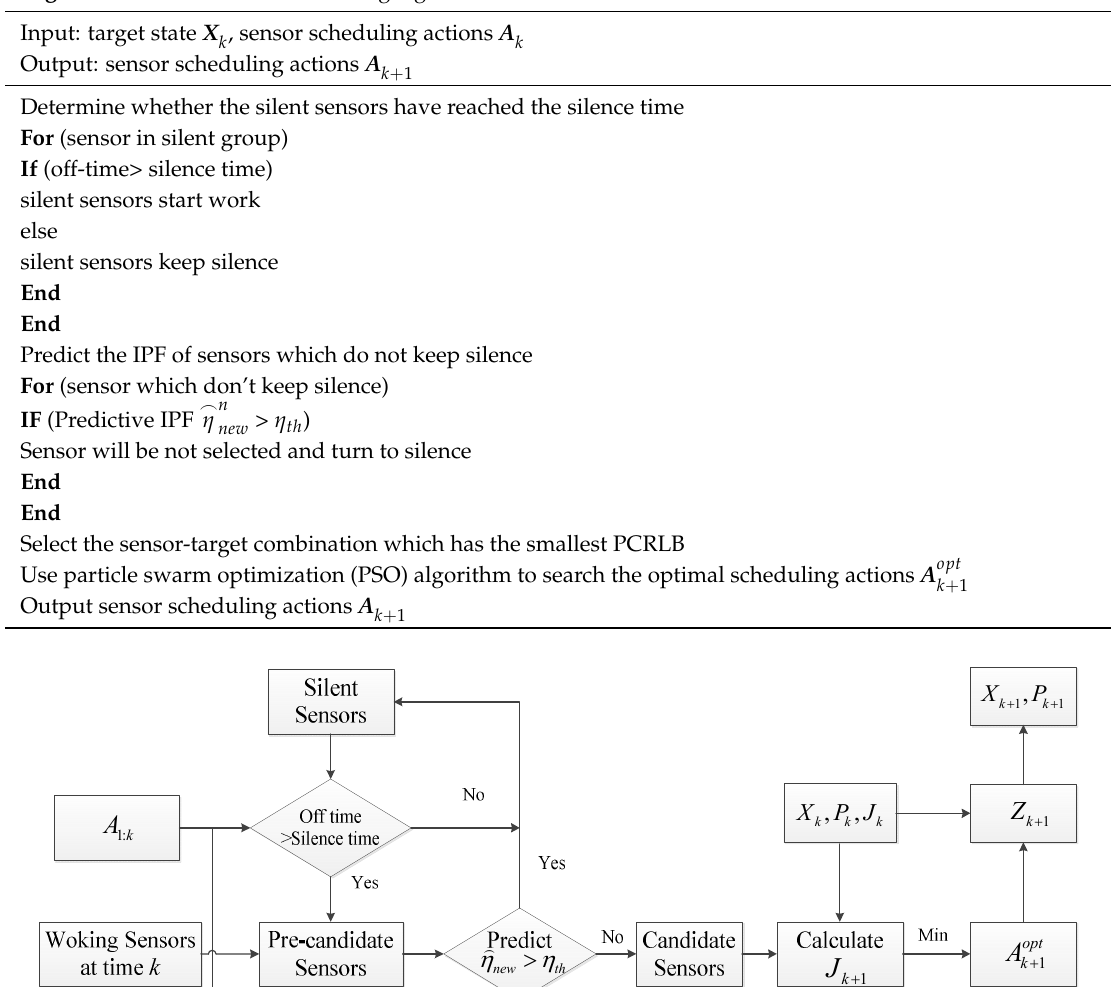
Algorithm 1 Multi-sensor scheduling algorithm